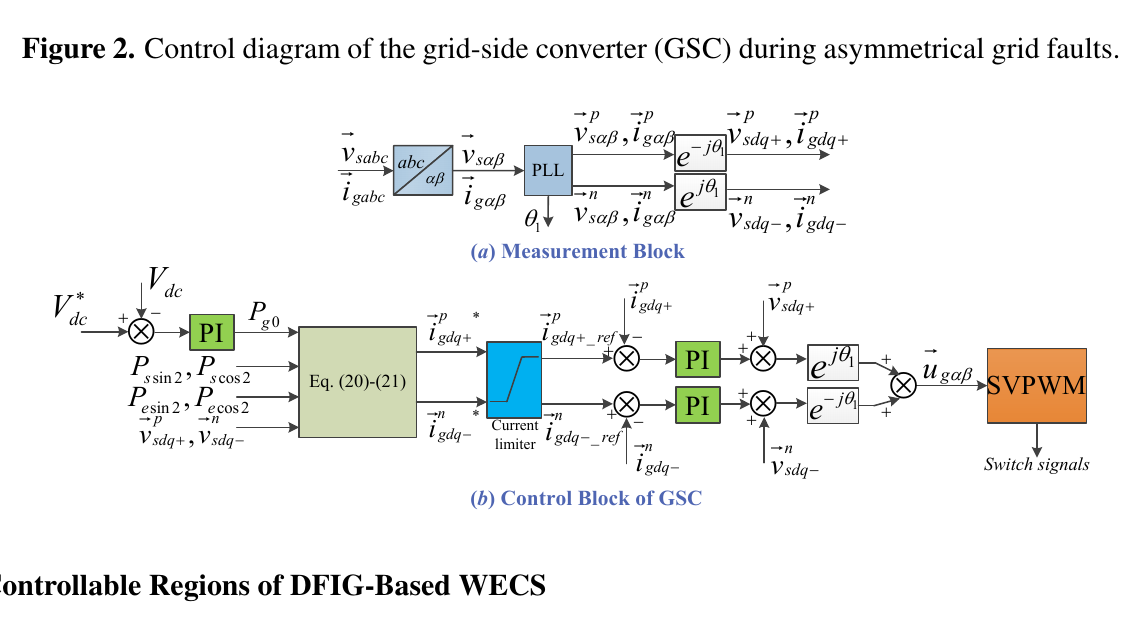
Figure 2. Control diagram of the grid-side converter (GSC) during asymmetrical grid faults.